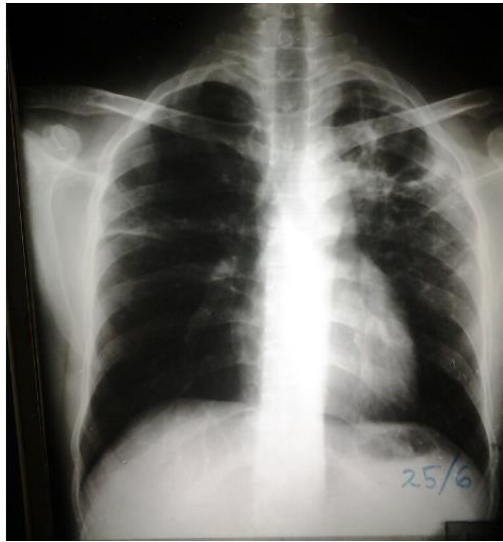
Figure 1. Chest radiograph showing a consolidation with cavity formation in the left upper lobe